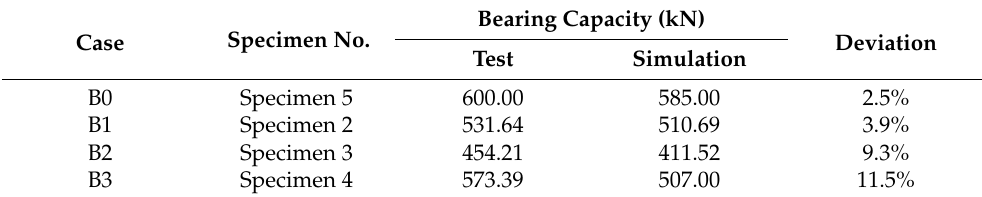
Table 10. Bearing capacity of the specimens between test and